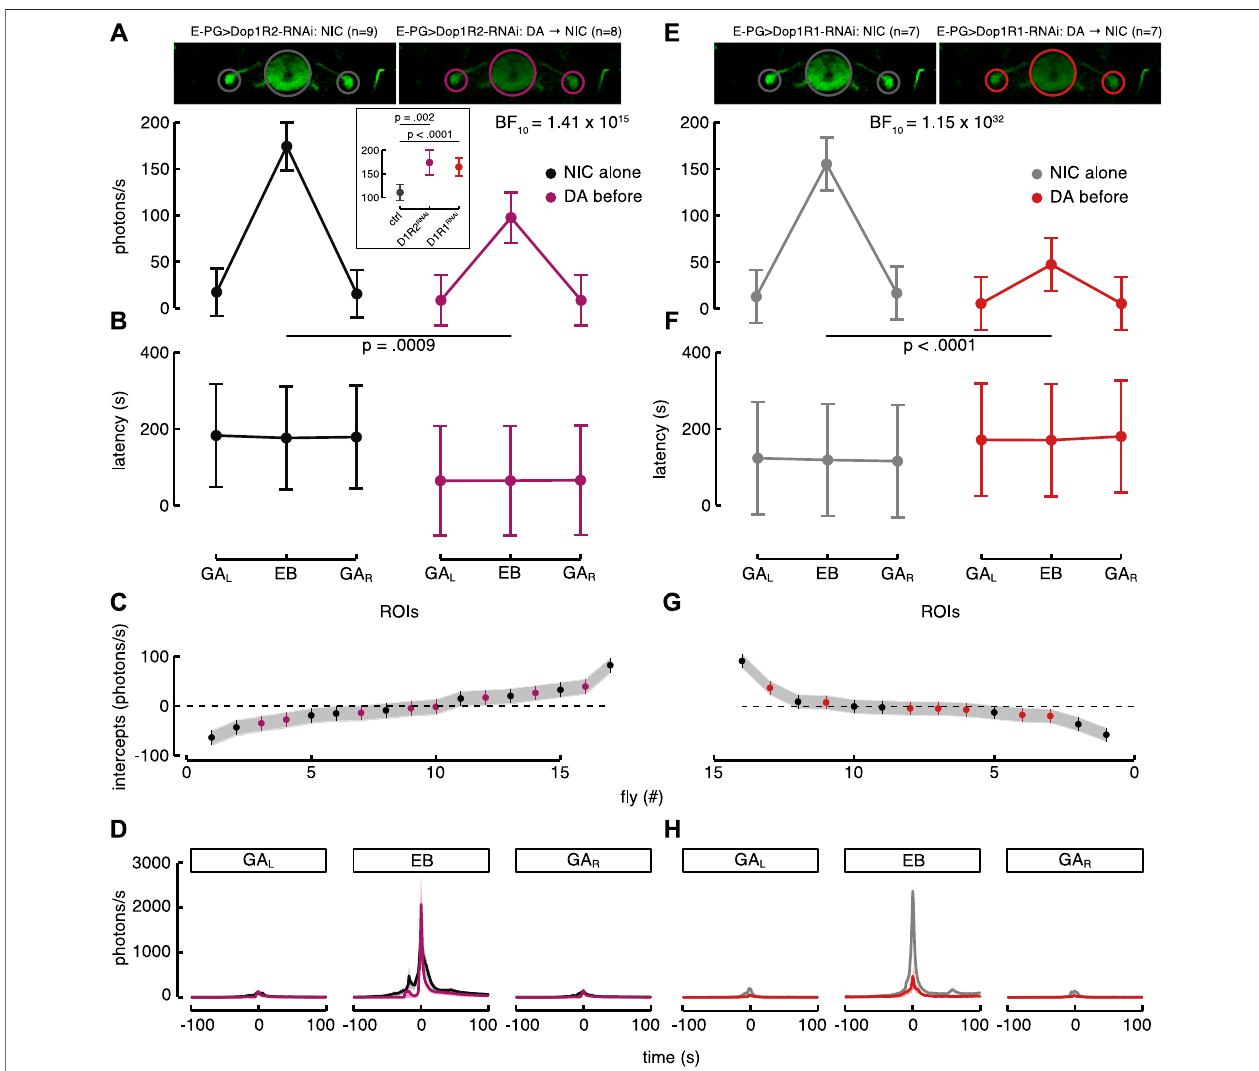
FIGURE 8 | Knockdown of Dop1R2 (A – D) and Dop1R1 (E – H) in E-PG > G5A fl ies. (A) Estimated parameters of the Ca 2+ -response referred to the interaction between condition and ROIs (as in Figure 5C ). The inset at the center represents the comparisons of the estimated interaction parameters (i.e., between condition and ROIs) referred to EB in the E-PG normal (ctrl), E-PG > Dop1R2-RNAi (D1R2 RNAi ) and E-PG > Dop1R1-RNAi (D1R1 RNAi ) fl ies in response to nicotine (post hoc comparisons adjusted with Bonferroni correction). On the left of the inset is represented the Ca 2+ -response to nicotine (NIC) alone in the three ROIs of the E-PG neurons with knockdown of Dop1R2 (E-PG > Dop1R2-RNAi; black, n = 9), while on the right is represented their Ca 2+ -response to nicotine after dopamine (DA) application (magenta, n = 8). (B) Estimated parameters of the response latency referred to the interaction between condition and ROIs in E-PG > Dop1R2-RNAi fl ies (computed as in Figure 5D ). On the left is represented the latency response to nicotine alone in the three ROIs of the E-PG neurons with knockdown of Dop1R2 (black) while on the right is represented their latency response to nicotine after dopamine application (magenta). (C) Plot of random effect referred to Ca 2+ -response of E-PG neurons with Dop1R2 knockdown (as in Figure 5E ). (D) Ca 2+ -response pro fi les to nicotine of the E-PG neurons with Dop1R2 knockdown in the three ROIs with (magenta)orwithout(black)dopamineapplicationbefore.Startingfromtheleft:leftGAregion,EBandrightGAregion. (E) EstimatedparametersoftheCa 2+ -responsein E-PG neurons with knockdown of Dop1R1 referred to the interaction between condition and ROIs. On the left the condition with nicotine (NIC) alone (E-PG > Dop1R1- RNAi; grey, n = 7) while on the right the condition with dopamine (DA) application before nicotine (red, n = 7). (F) Estimated parameters of the response latency in E-PG neurons with knockdown of Dop1R1 referred to the interaction between condition and ROIs (computed as in Figure 5D ). On the left the condition with nicotine alone (grey)while ontherighttheconditionwithdopamine applicationbeforenicotine (red). (G) Plotofrandomeffectreferred toCa 2+ -responseofE-PG neuronswithDop1R1 knockdown. (H) Ca 2+ -response pro fi les to nicotine of the E-PG neurons with Dop1R1 knockdown in the three ROIs de fi ned as in G with (red) or without dopamine application before (grey).